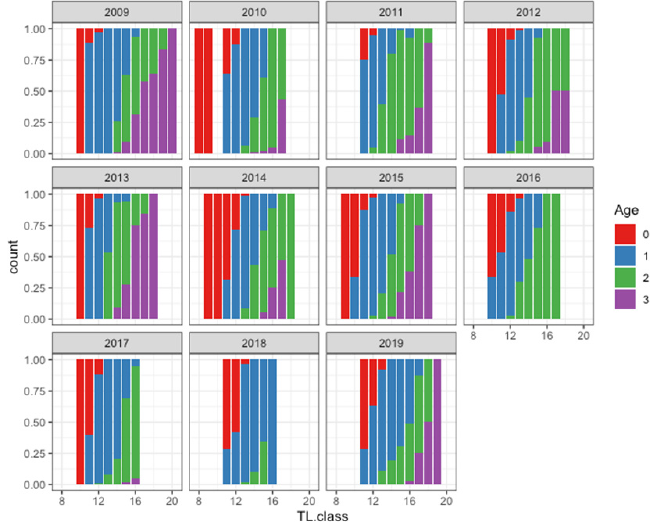
Figure 5. The age-length key (ALK) for sardine estimated during the study period (11 years: 2009–2019). Total length (TL) is in